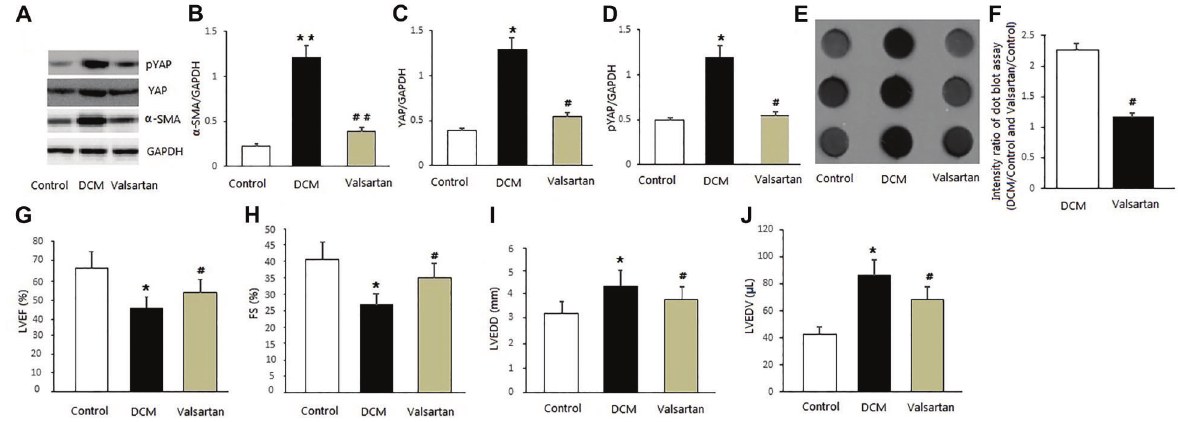
Figure 4. Inhibition of angiotensin II (Ang II)-stimulated Yes-associated protein (YAP) can improve cardiac function. A – D , Inhibition of inner Ang II-stimulated YAP resulted in a decrease in the protein levels of YAP, pYAP, and a -smooth muscle actin ( a -SMA) in the valsartan-treated group. E and F , The expression of collagen I was signi fi cantly decreased to attenuate matrix remodeling in the valsartan-treated group compared to the dilated cardiomyopathy (DCM) group in dot blotting analyses. G and H , Cardiac function differed signi fi cantly between the groups, and the left ventricular ejection fraction (LVEF) and fractional shortening (FS) signi fi cantly improved in the valsartan group. I and J , Left ventricular end-diastolic dimension (LVEDD) and left ventricular end-diastolic volume (LVEDV) were signi fi cantly decreased in the valsartan group. Data are reported as means ± SD (n=8). *P o 0.05, **P o 0.05 vs Control; # P o 0.01, ## P o 0.01 vs DCM